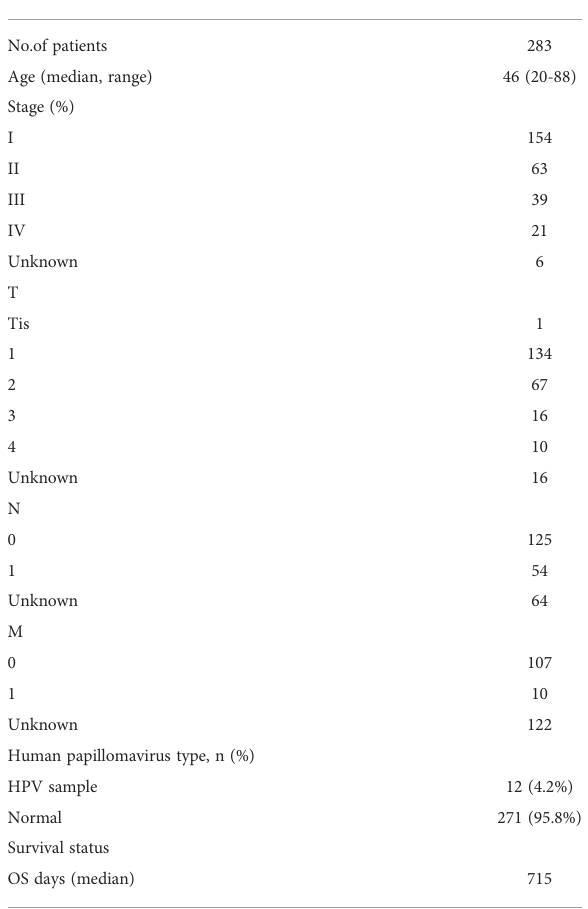
TABLE 1 The distribution of clinical characteristics of cervical cancer patients.